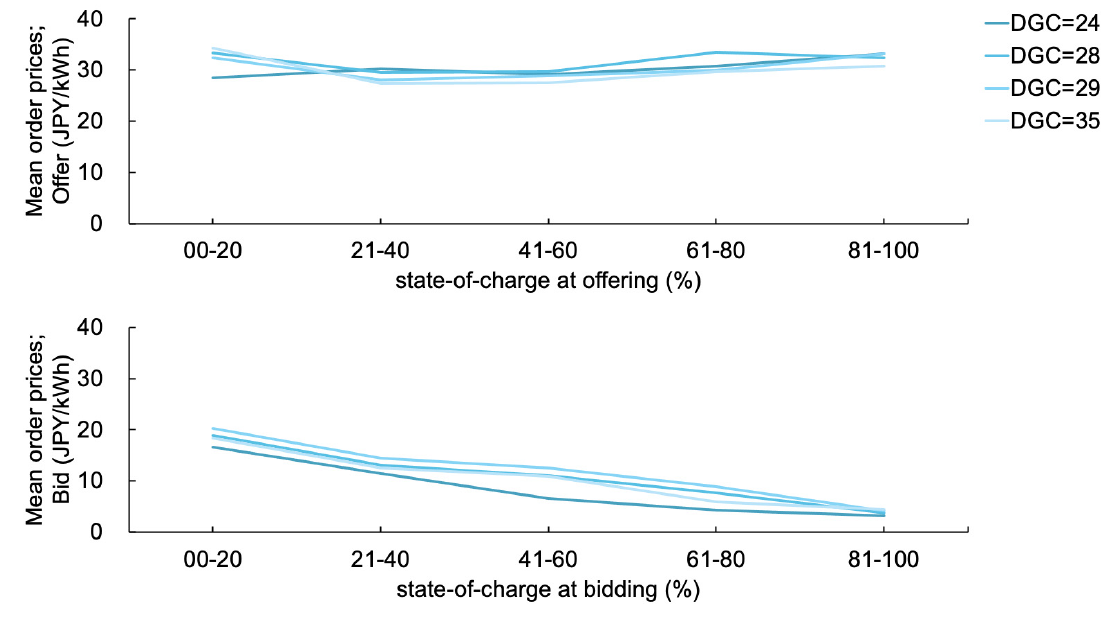
Figure 16. Mean order prices for each SoC in the target period.